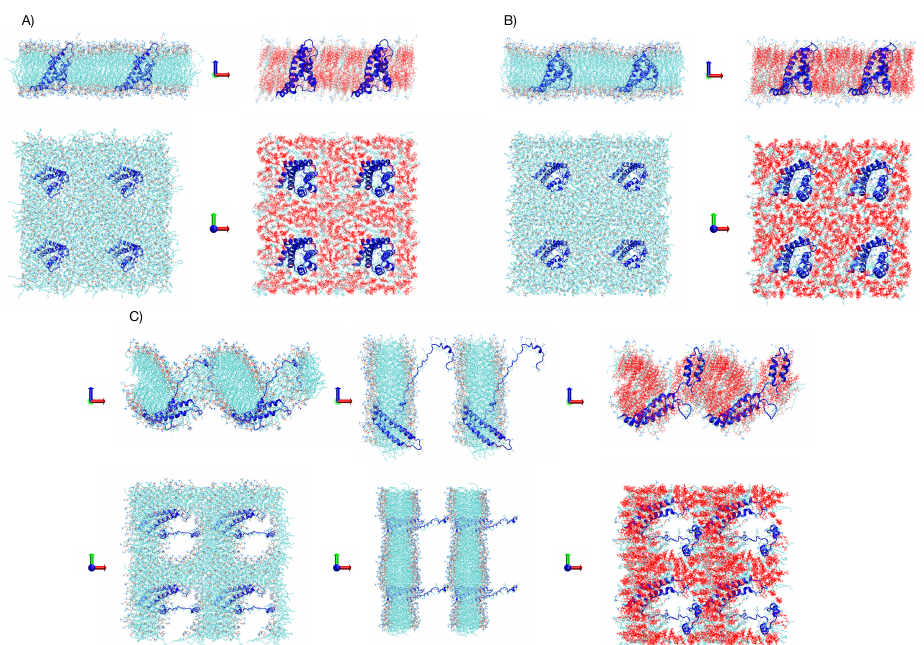
Figure 5. Bilayer and the VSD of Box 1 and 2 with 3 periodic images in x and y, views from beside and up. Cholesterol in Box 2 highlighted in red. ( A ) Box 1 and Box 2 after 200 ns of simulation under an (cid:126) E = 0.0 V/nm. ( B ) Box 1 and Box 2 after 50 ns of simulation under an (cid:126) E = 0.1 V/nm. ( C ) Box 1 and Box 2 after 50 ns of simulation under an (cid:126) E = 0.2 V/nm. On the left of the panel ( C ), an additional membrane/VSD representation at 15 ns of simulation is shown to illustrate that the disruption of the membrane in Box 1 starts from similar pores as observed in Box 2.